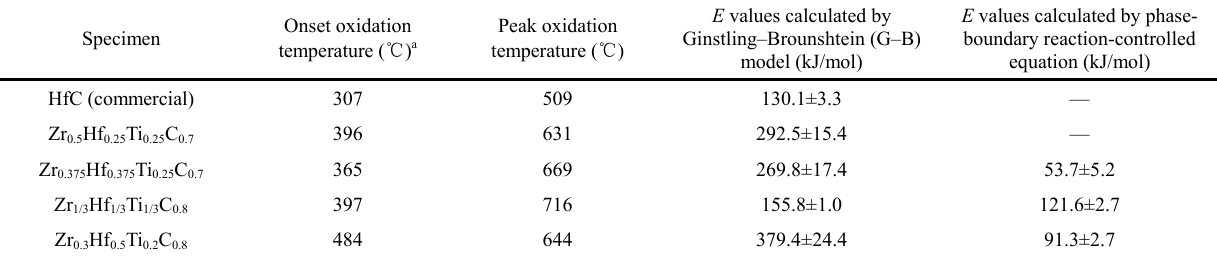
Table 3 Onset oxidation temperatures, peak oxidation temperatures, and E values of